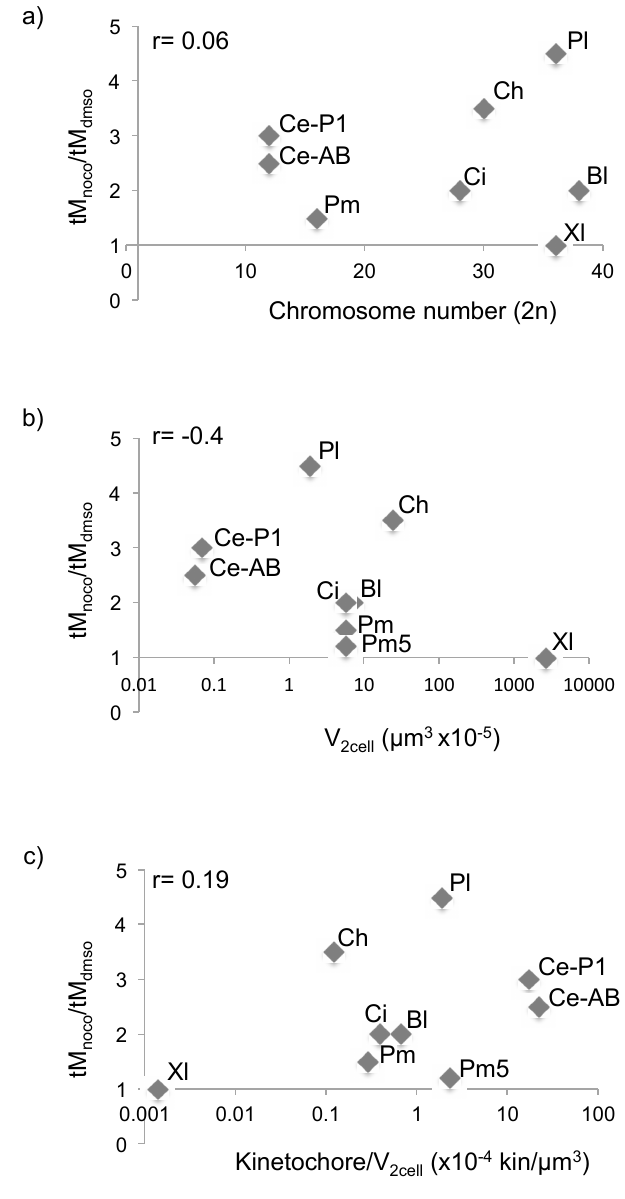
Figure 5. SAC response across species does not correlate with cell volume. ( a – c ) Ratio of average mitotic duration in nocodazole- and DMSO-treated embryos plotted against ( a ) chromosome number, ( b ) cell volume at 2-cell stage or ( c ) kinetochore / cell volume ratio at 2-cell stage. Bl = B. lanceolatum , Ci = C. intestinalis, Ce = C. elegans , Pl = P. lividus , Pm = P. mammillata , Pm5 = ratio after 4 cycles in nocodazole from Figure 3b, Ch = C. hemisphaerica and Xl = X. laevis . For Bl and Ci , mitotic duration was estimated from the time course graphs in Figure 4a,d, as width of the curve at 50% level. Ce and Xl data were obtained from the literature. For Ce , as the first division is asymmetric, both cells are presented (AB and P1). r indicates the coe ffi cient of correlation for each set of